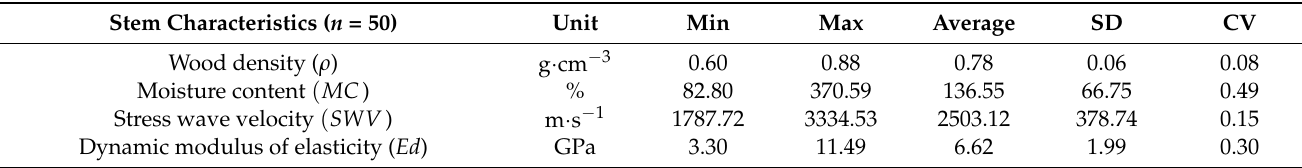
Table 3. Average values of wood density, moisture content, stress wave velocity, and dynamic modulus of elasticity (MOE) of standing rain trees ( n = 50).